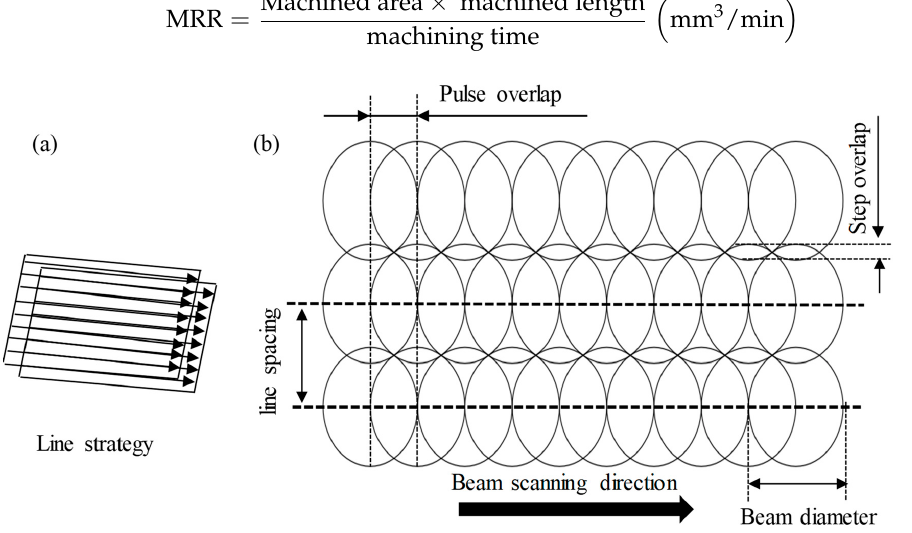
Figure 4. ( a ) Laser scanning strategy; ( b ) schematic of the adjacent laser tracks. The cross-section of the machined area was calculated from the fitted 2D profile, as shown by the grey-filled area in Figure 5c. The cross-sectional area of the four profiles was averaged and then used in Equation (1).